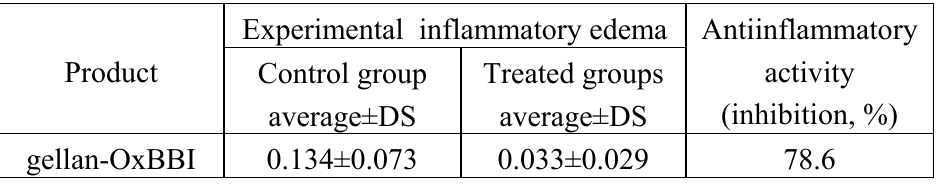
Table 1. Investigation of the antiinflammatory activity of gellan-OxBBI on